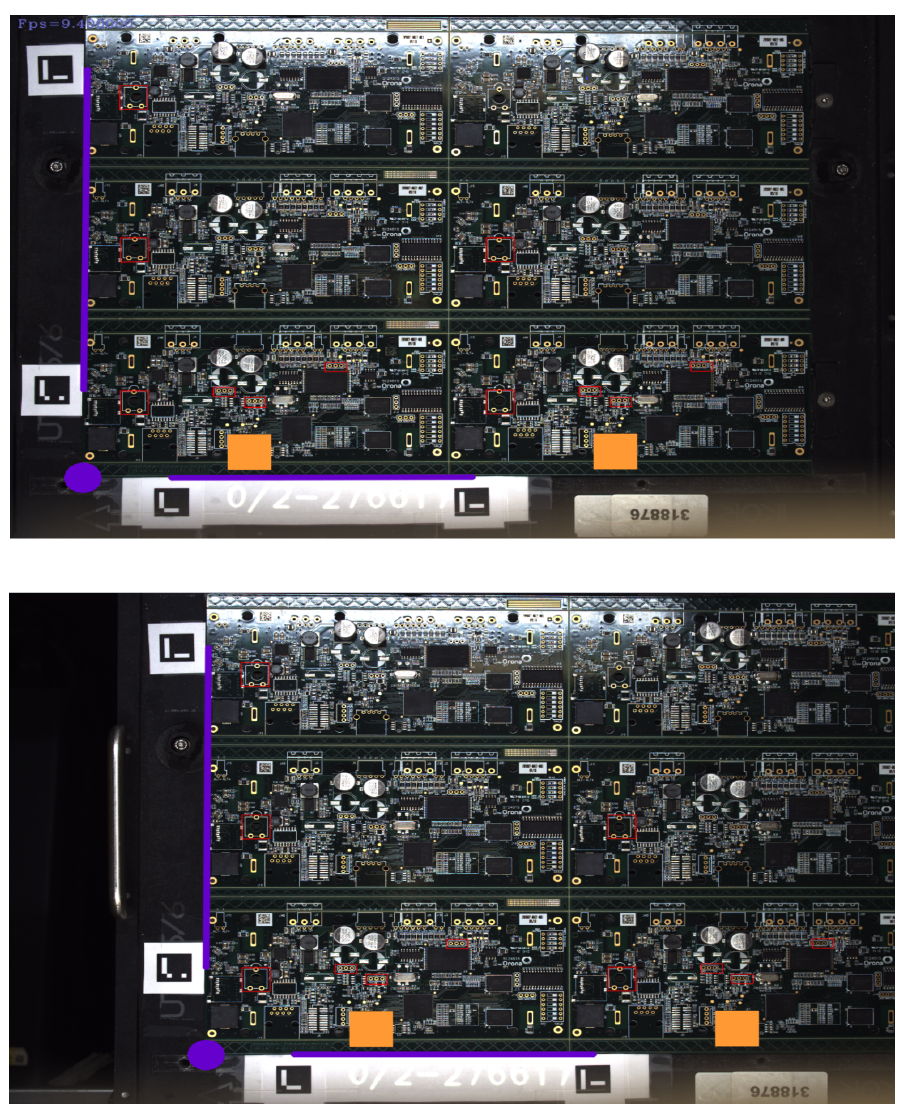
Figure 3. Images where the printed circuit boards (PCB) is in different positions. The purple lines are located thanks to the ArUco markers; the corner (purple circle) is the intersection between them and denotes the PCB reference